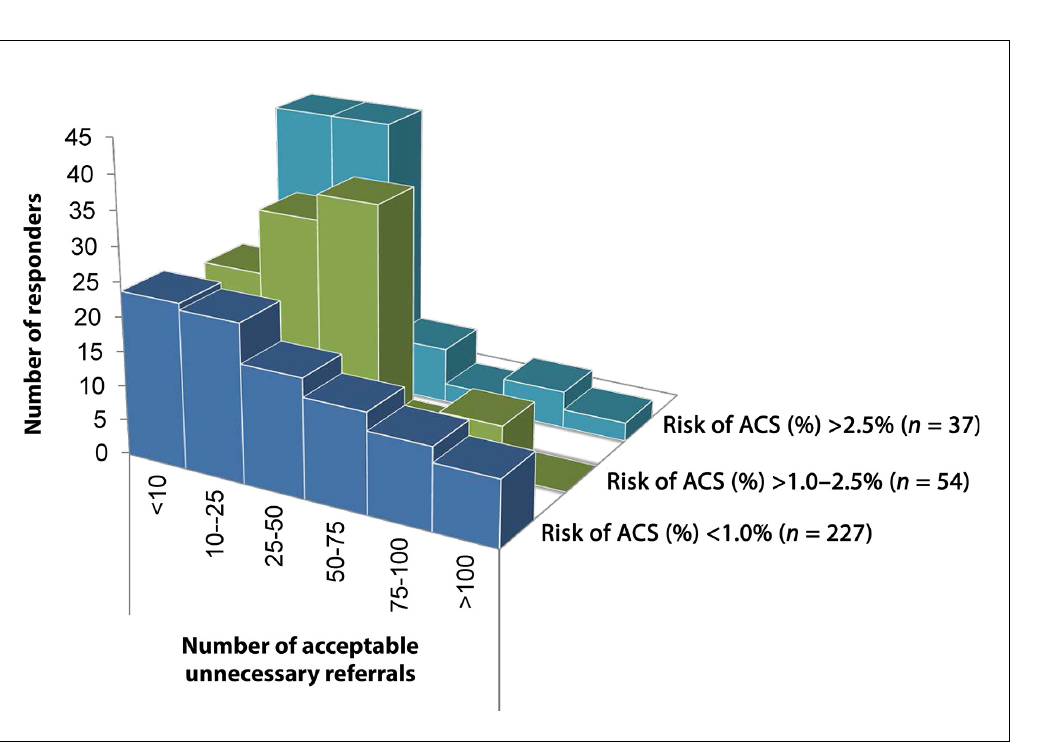
Figure 2. Number of referrals stratified by acceptable risk of failed-to-recognise ACS among atypical presentations. ACS = acute coronary syndrome.